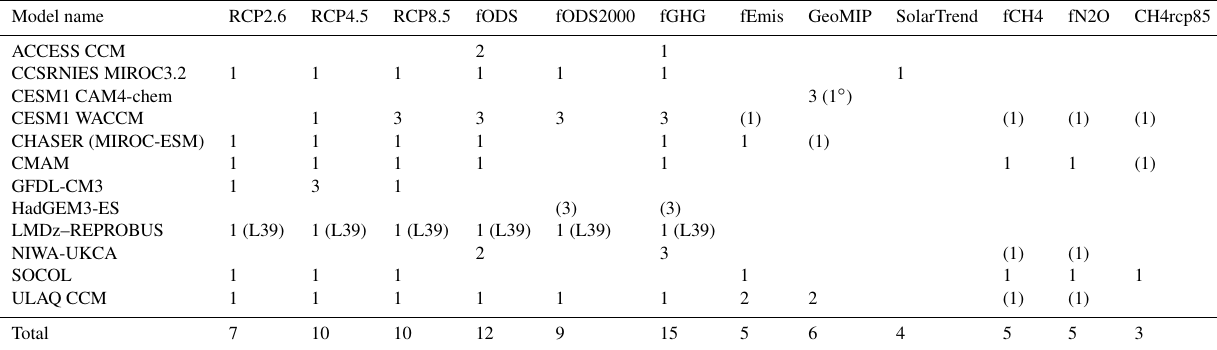
Table 6. SEN-C2 sensitivity simulations, by